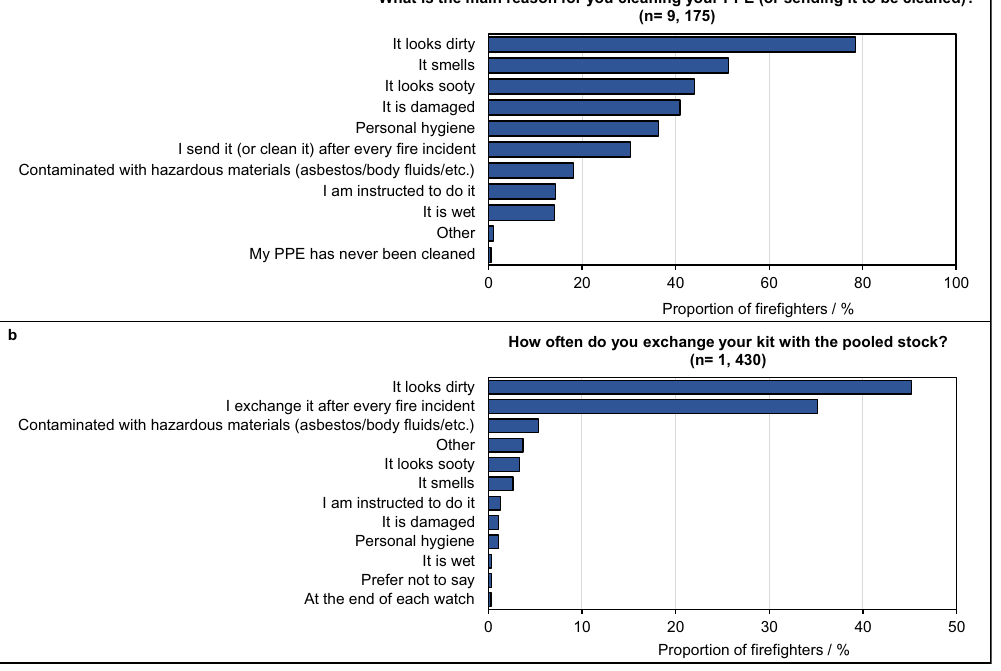
Figure 4. Reasons for cleaning/exchanging PPE in the UK Fire and Rescue Service. ( A ) The proportion of firefighters with individually issued PPE indicating their reasons for cleaning their PPE. ( B ) The proportion of firefighters with pooled PPE indicating their reasons for exchanging PPE with the pooled